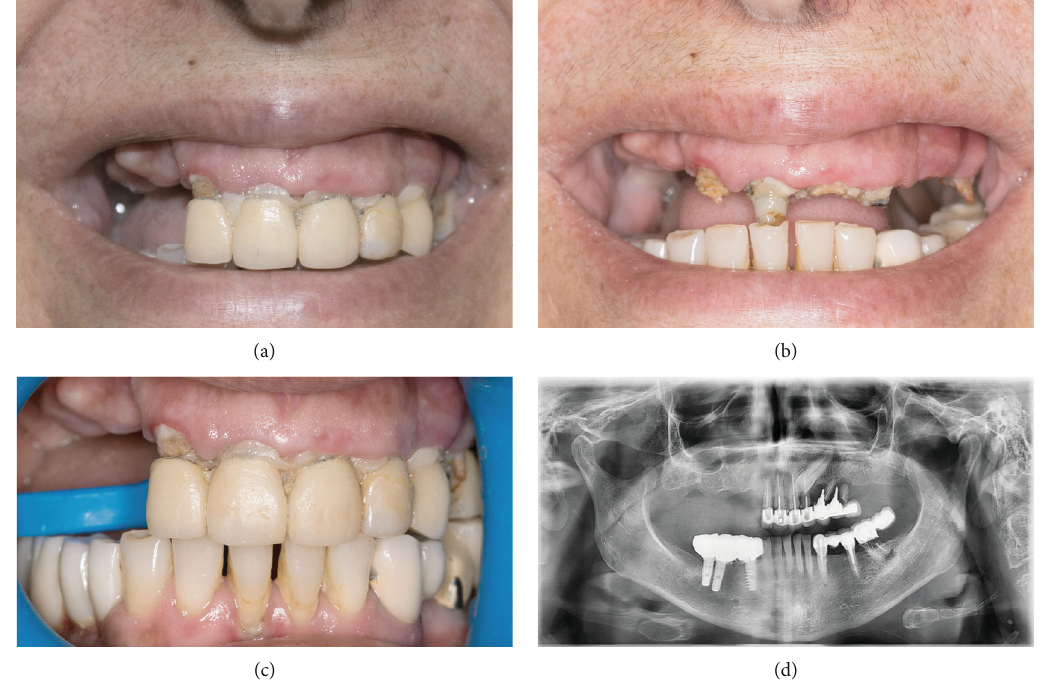
Figure 1: Baseline: (a – c) clinical situation of the patient at the baseline. (d) Radiological situation at the